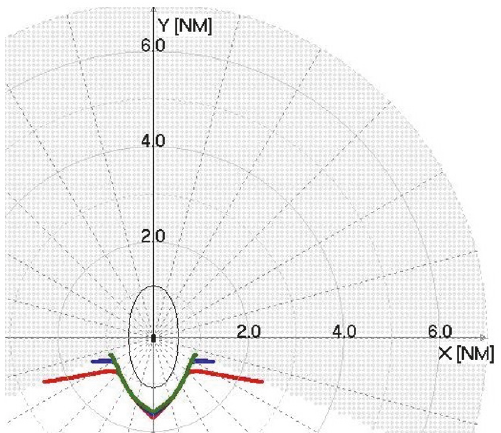
Figure 13: Action lines for being overtaken by a target, whose true speed is 23 knots. Turns to both sides are considered depending on target’s relativebearing. Turns arelimited to15 ∘ (red), 20 ∘ (blue),and 60 ∘ (green). No speed reduction.